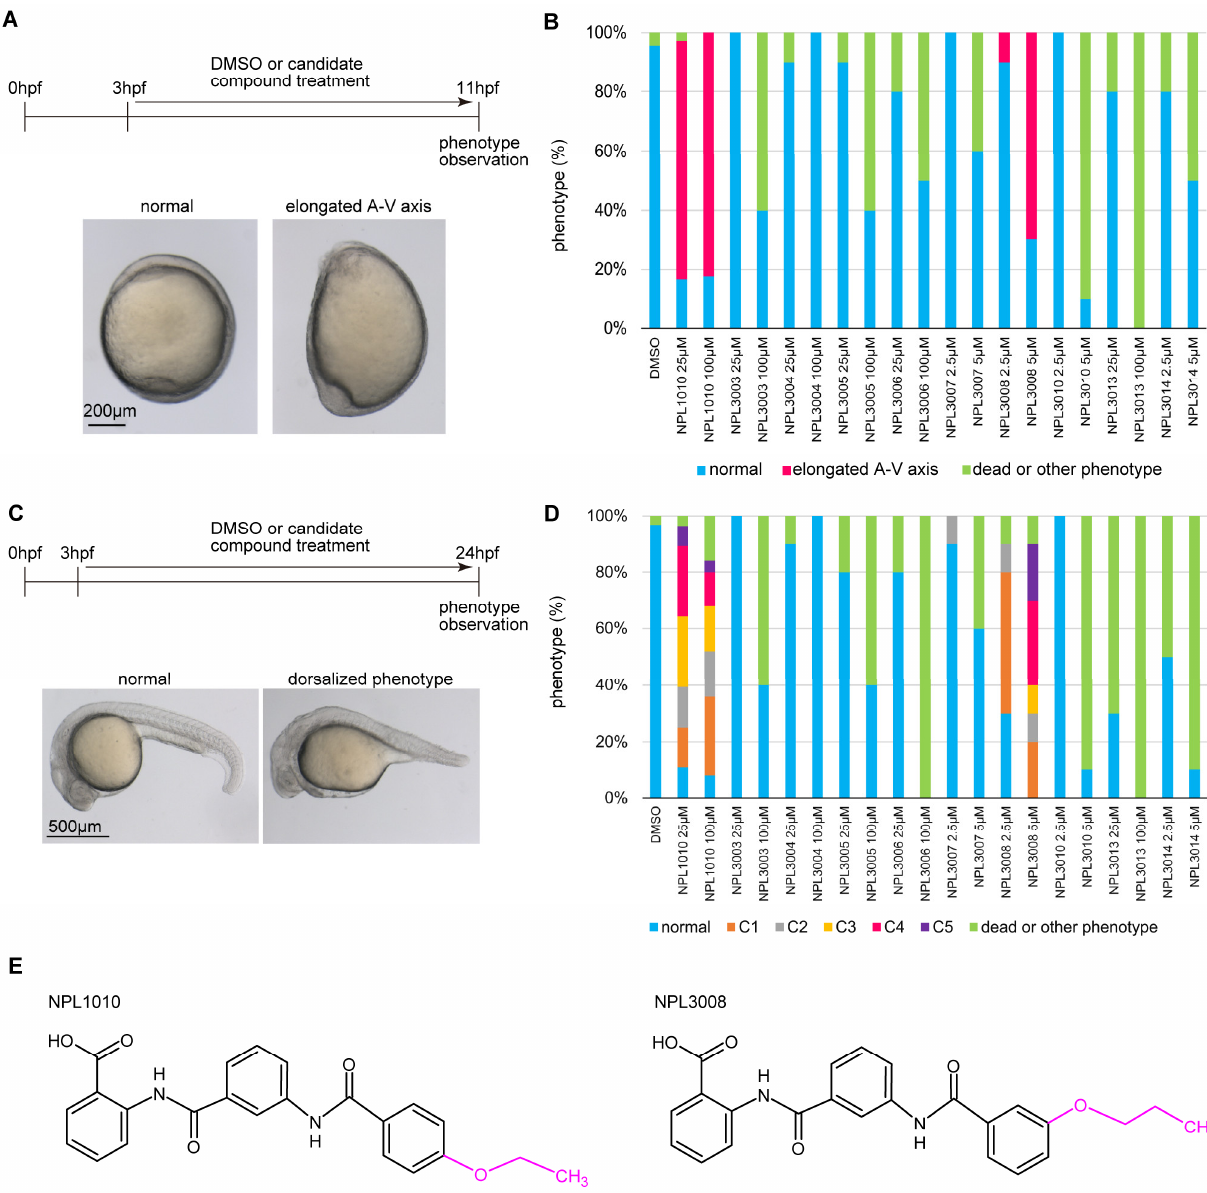
Figure 1. Screening chemical compounds using zebrafish embryos. ( A ) Schematic diagram of the phenotype screen performed at 11 hpf (upper panel), with the representative normal and elongated A-V axis phenotypes shown in the photographs (bottom panels). Scale bar, 200 μm. ( B ) The propor- tion of phenotypes observed in zebrafish treated with compounds at 11 hpf ( n = 10–45). ( C ) Schematic diagram of the phenotype screen at 24 hpf (upper panel) with the representative normal and dorsalized phenotypes shown in the photographs (upper panel). Scale bar, 500 μm. ( D ) The proportion of zebrafish presenting the dorsalized C1−C5 phenotypes after treatment with compounds at 24 hpf ( n = 10–45). ( E ) The molecular structures of NPL1010 and NPL3008. These compounds share a common structure (black line and letters), but the ether group length and position differ (magenta line and letters).